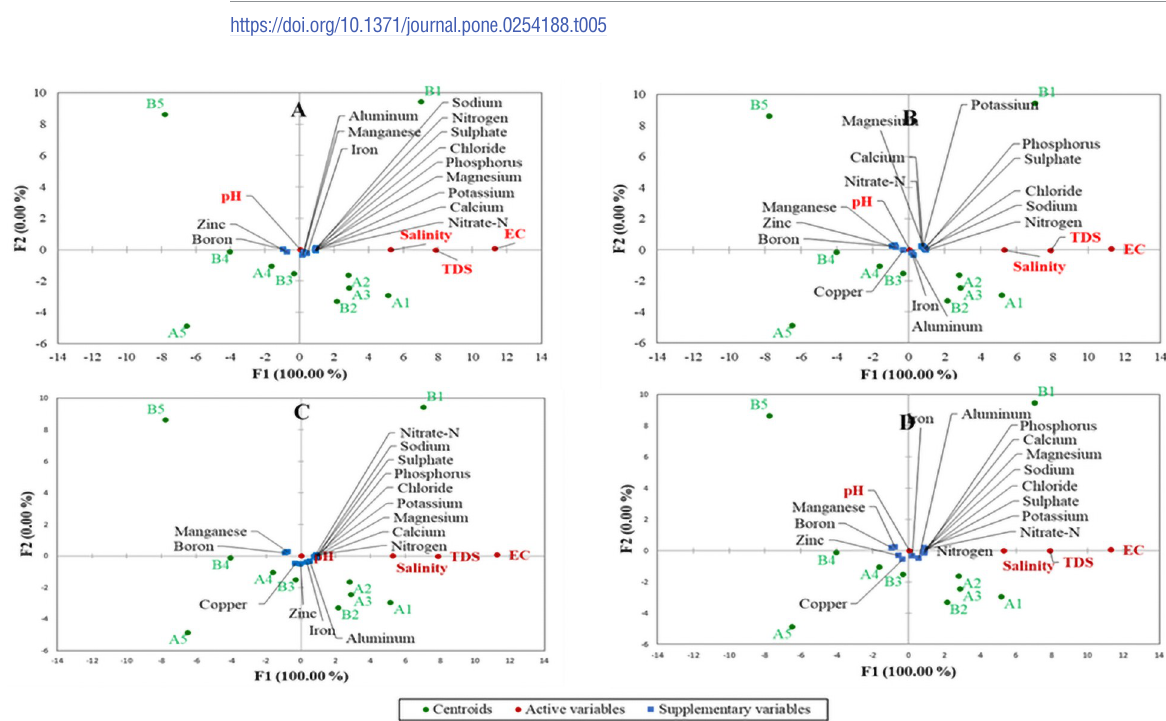
Table 5. Least-squares mean of electric conductivity for T . viride main effect for vermicast-sawdust mixed media without (A) and with (B) Trichoderma viride in a nutrient release experiment. Effect Estimate P-value Without T . viride With T . viride n = 3 per experimental replicate.